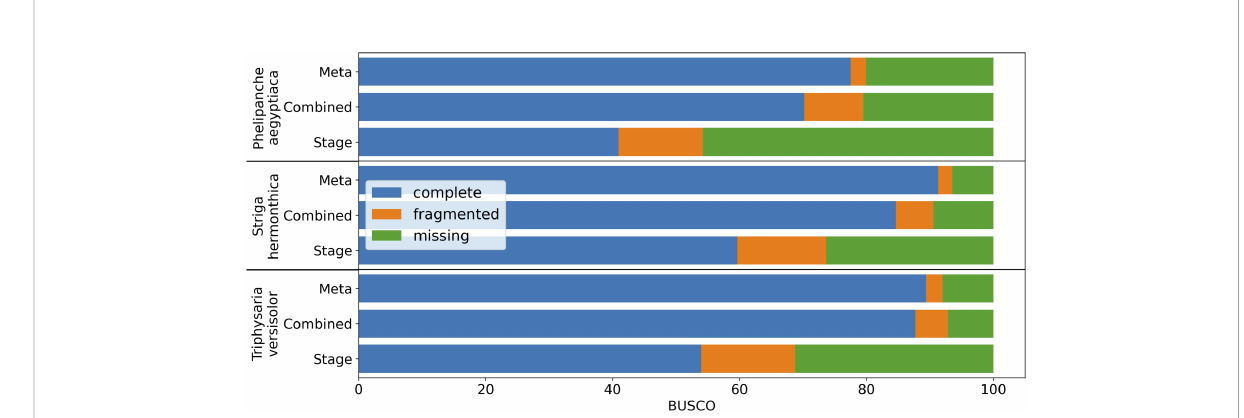
FIGURE 6 BUSCO completeness assessment of transcriptome assemblies to illustrate the results from targeted gene family assembly (meta-assembly) function in the PlantTribes2 AssemblyPostProcessor tool compared to Trinity approaches. Color bars indicate complete (blue), fragmented (orange), and missing (green) BUSCOs. Assemblies of parasitic plants, Phelipanche , Striga , and Triphysaria , examined include (1) developmental stage-speci fi c assemblies (Stage, only the average of all the stages were shown in the plot), (2) assemblies combining all stage-speci fi c raw data (Combined), and (3) meta-assembly of stage-speci fi c assemblies and combined assembly (Meta) using AssemblyPostProcessor .